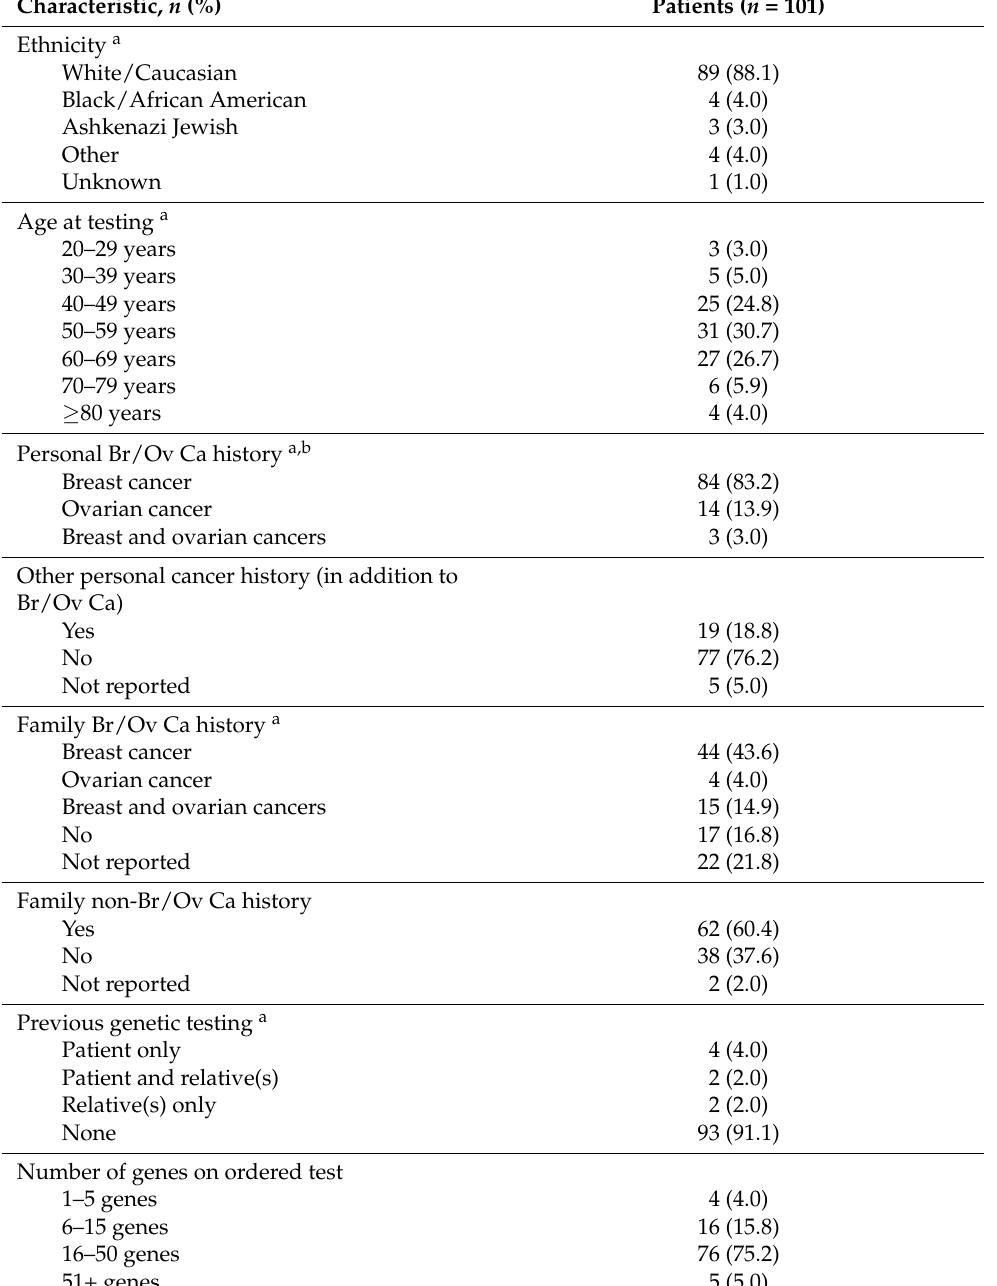
Table 1. Demographics and clinical characteristics of 101 female patients with P/LP variants in genes beyond BRCA1 and BRCA2